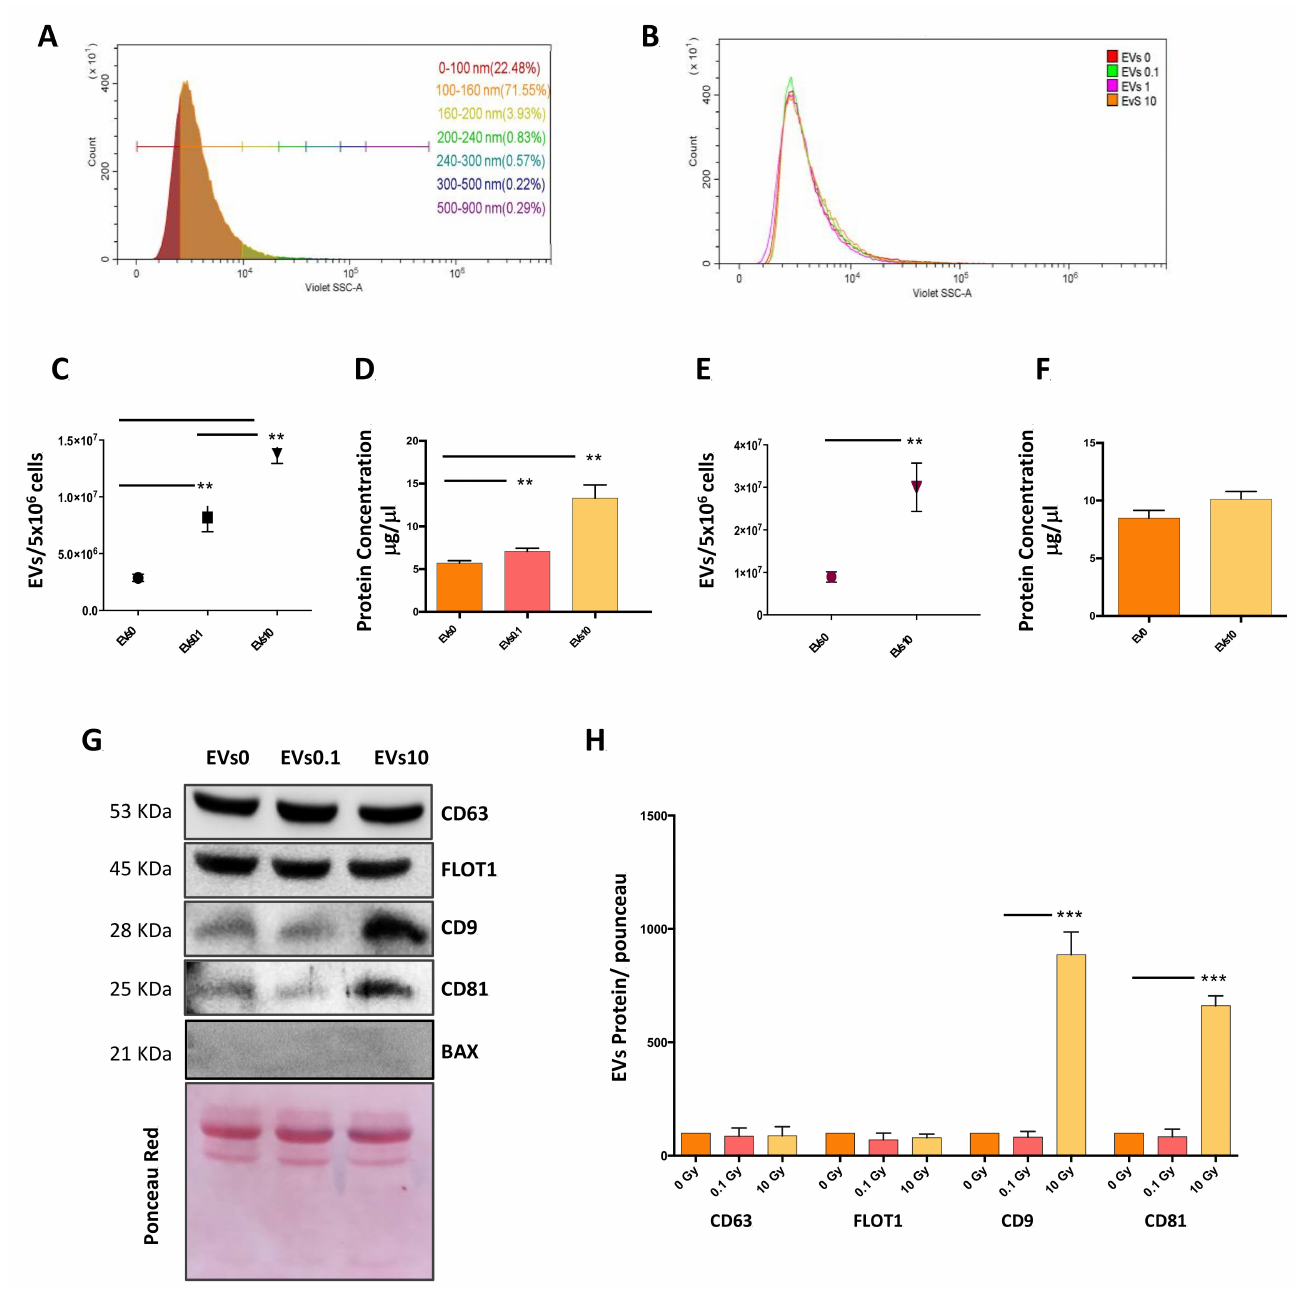
Figure 1. Characterization of extracellular vesicles (EVs) released by non-irradiated/irradiated neuroblastoma cells. ( A ) Representative histogram of the size distribution of EVs released by SH-SY5Y neuroblastoma cells. Size ranges are indicated by different colors in the horizontal bar; ( B ) Representative distribution dimension curves of EVs released by non- irradiated and irradiated neuroblastoma cells; ( C ) Quantitative analysis of SH-SY5Y EVs by flow cytometry (EVs/5 × 10 6 cells); ( D ) Protein quantification of SH-SY5Y EVs; ( E ) Quantitative a nalysis of SK-N-BE EVs by flow cytometry (EVs/5 × 10 6 cells); ( F ) Protein quantification of SK-N-BE EVs; ( G ) SH-SY5Y EVs were analyzed by Western blot to measure CD63, FLOT1, CD9, and CD81 protein levels. Ponceau Red staining and Bax were used as loading and negative control, respectively; ( H ) Densitometric relative to three western blots. Data are expressed as mean ± S.D. (n = 3, **, p < 0.01 ***, p < 0.001 vs. EVs0 or